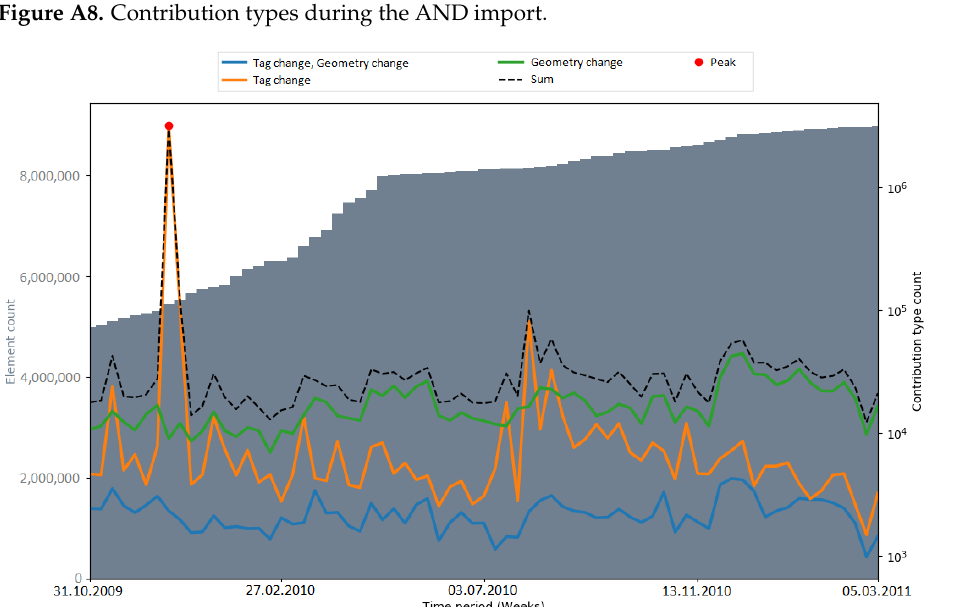
Figure A9. Contribution types during the 3dShapes